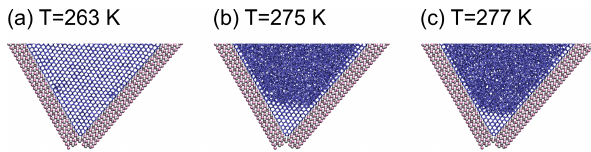
Figure 10. Simulations of ice in the W 70 wedge system persisting above the melting point using the mW model. Last frame at (a) T = 263K at time t = 10ns, (b) T = 275K and (c) T = 277K at time t = 40ns after heating to this temperature gradually from T = 263K. Ag and I ions are shown in silver and pink, respectively, and the hydrogen bond network between mW water molecules is shown by blue